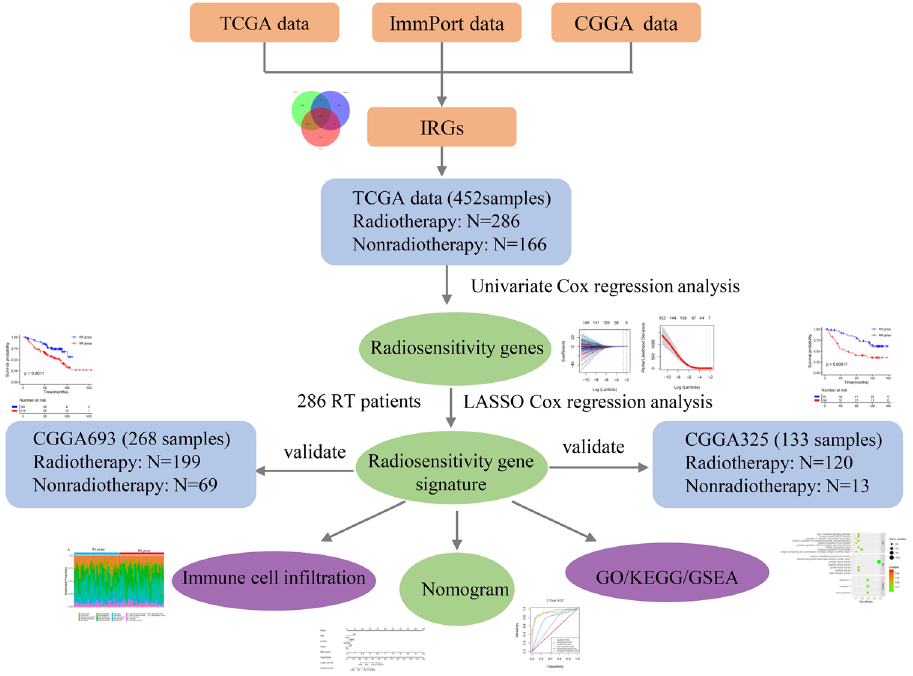
Figure 1. The workflow of this